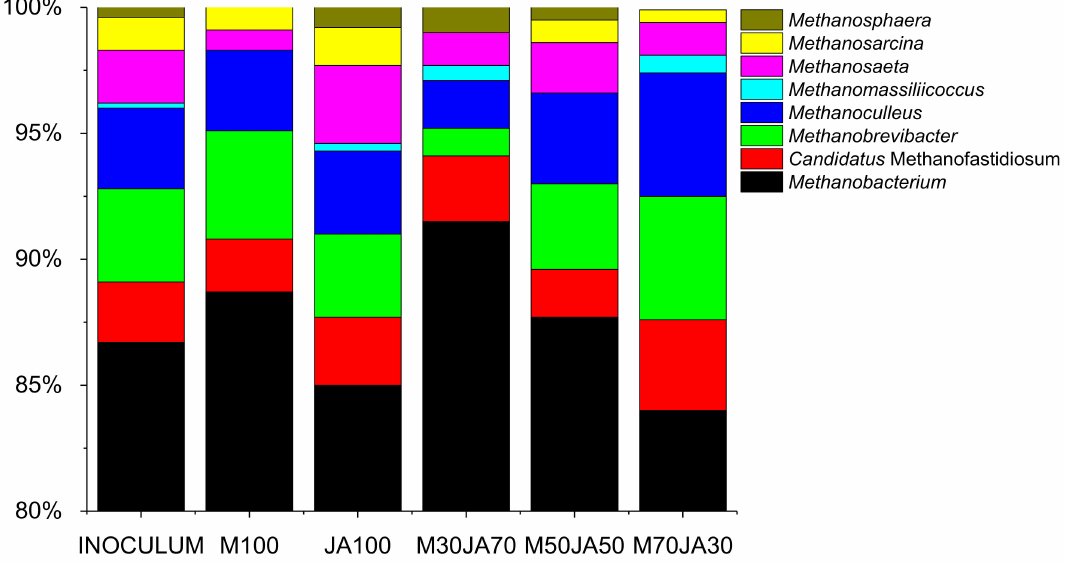
Figure 4. Silage samples archaeal 16S rRNA genes relative abundance at the genus level, based on the average ASV reads from triplicates. Sampled on day 35, except the inoculum, which was sampled on day